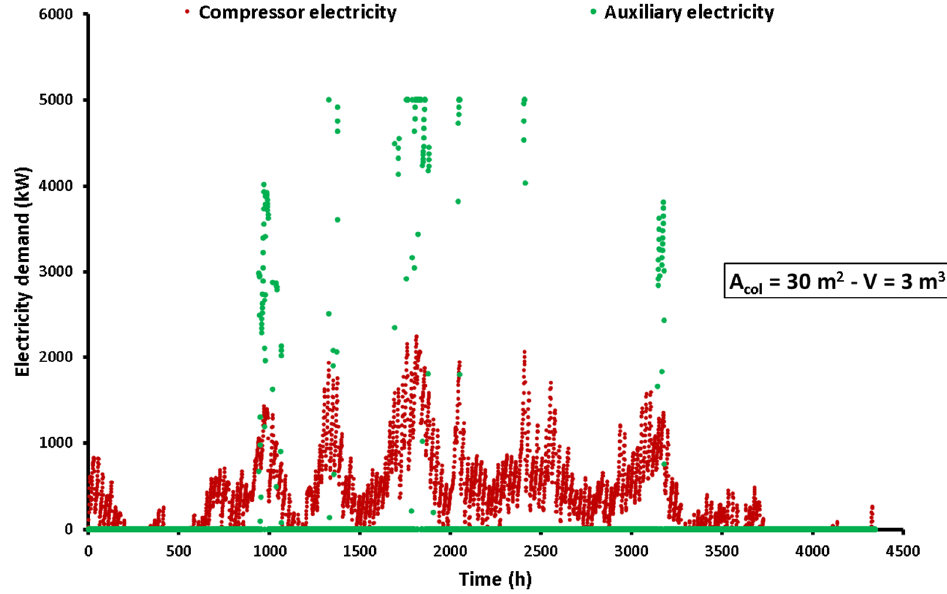
Figure 7. Electricity demand for the compressor and the auxiliary electrical resistance in the tank for the case with 30 m 2 collecting area and 3 m 3 tank volume (1 October to 30 April).